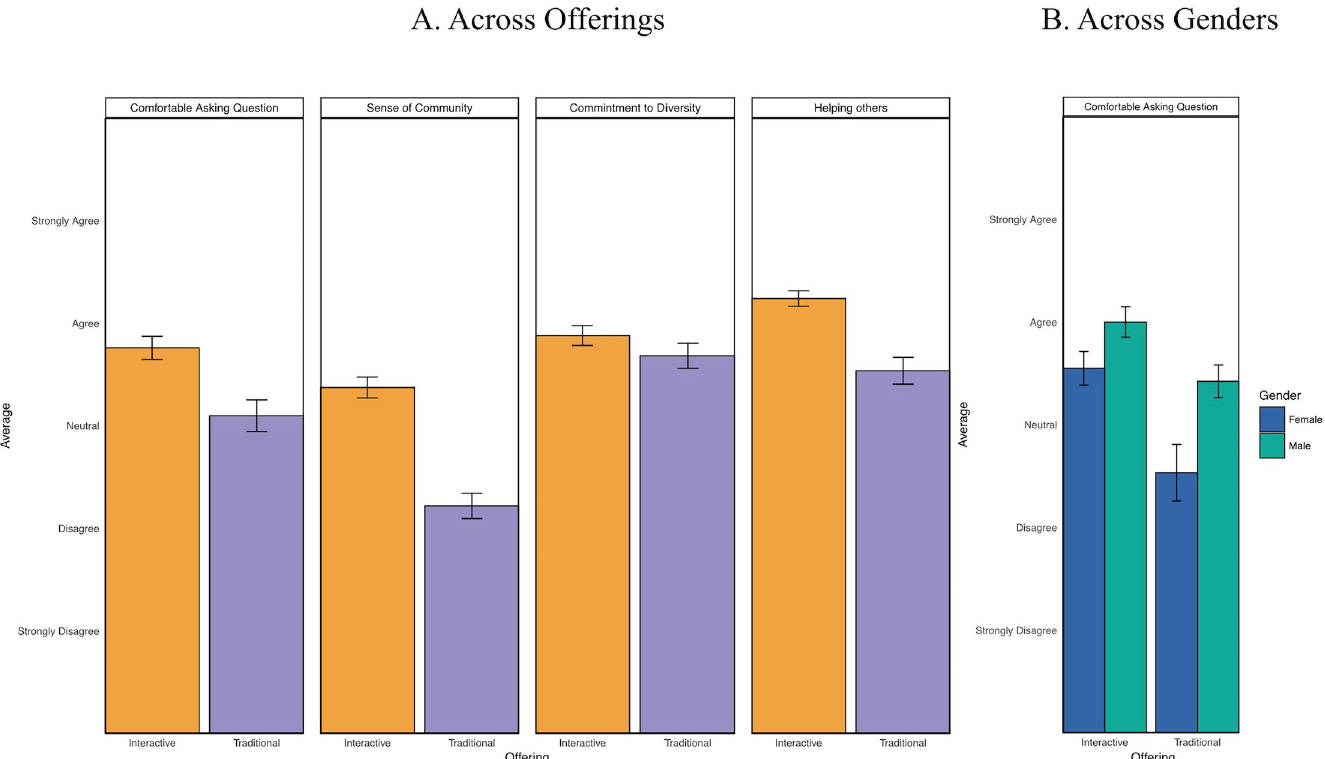
Fig 4. A. Average responses to the perception questions. B. Responses to “Comfortable asking questions” item broken down by gender and course offering. This was the only item that showed a significant gender difference. The error bars represent standard errors.